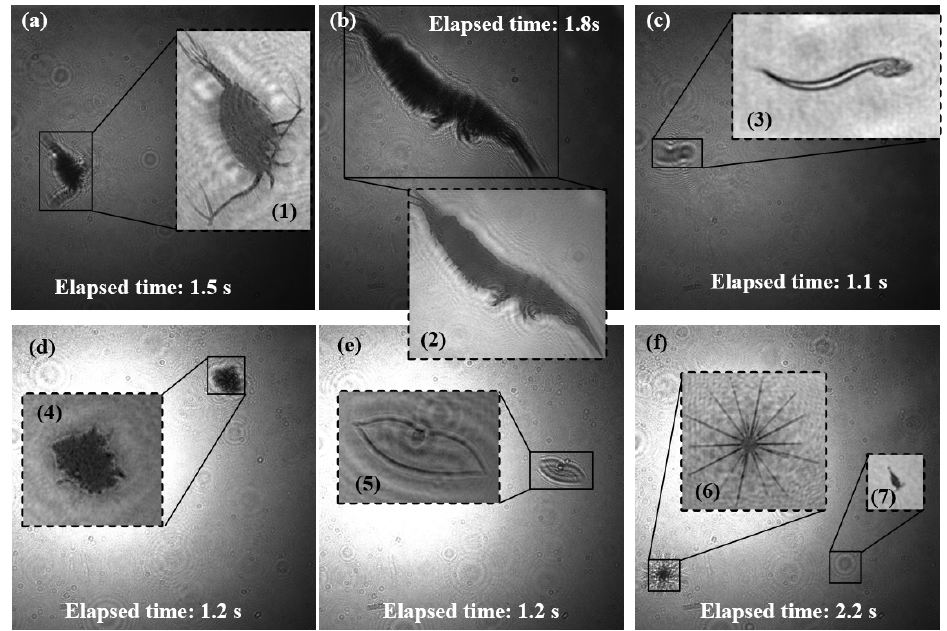
Figure 15. Montages obtained by processing the holograms of Figure 4a–f using the algorithm proposed in this paper. ( a – f ) with processing times respectively of 1.5 s, 1.8 s, 1.1 s, 1.2 s, 1.2 s, 2.2 s. (1–7) are extracted plankton images.